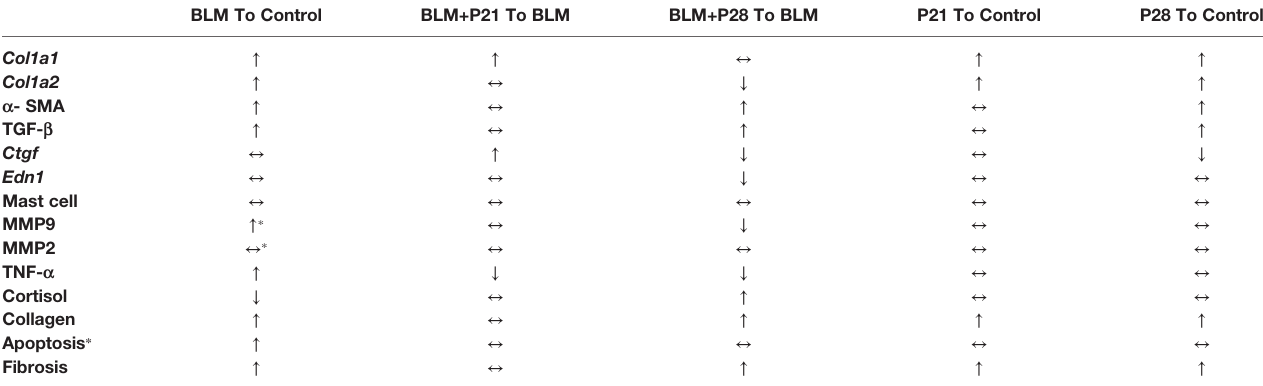
TABLE 2 | Results of the study.